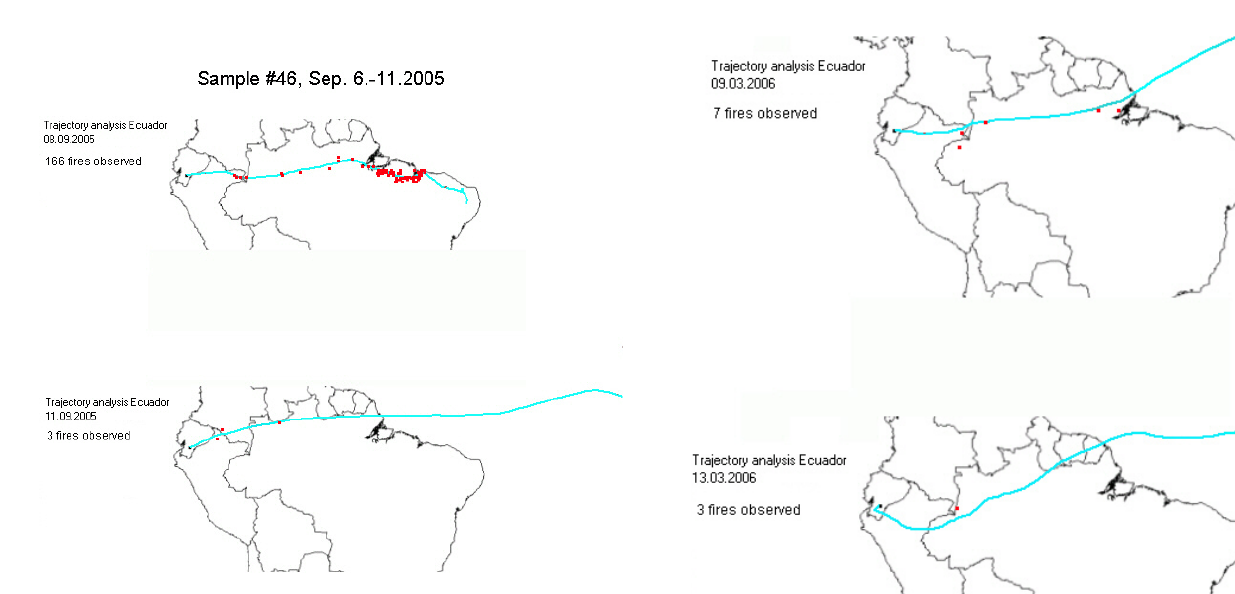
Fig. 10. Same as Fig. 8, but for sample #46.